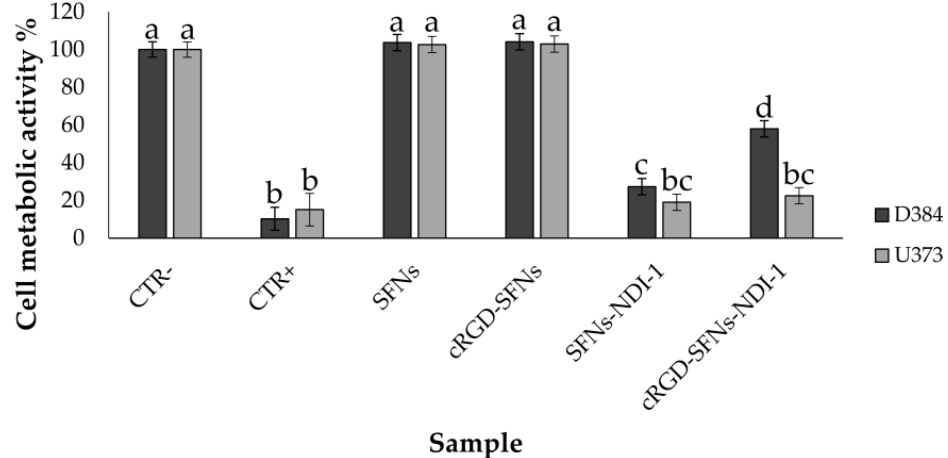
Figure 5. Cytotoxic effect of samples tested at 0.1 mg/mL on U373 (expressing integrin subunits) and D384 (expressing integrin subunits in lower amounts) cell lines after 72 h. Untreated cells were considered CTR- (100% of metabolic activity), while 1 µ M of NDI-1 was considered CTR+. Multifactor ANOVA, mean values ± least significant difference (LSD), n = 4 from two independent experiments. Letters (a, b, bc, c, and d) are used to compare the means of different groups. If the letters are different, there is a statistically significant difference between the means ( p < 0.05); if the letters are the same, there is no statistically significant difference between the means ( p > 0.05).